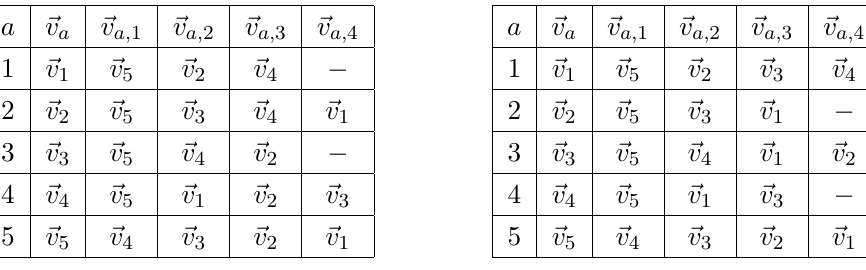
Table 7 . Vectors used to compute the master volume for the two resolved geometries given in (cid:12)gure 6,